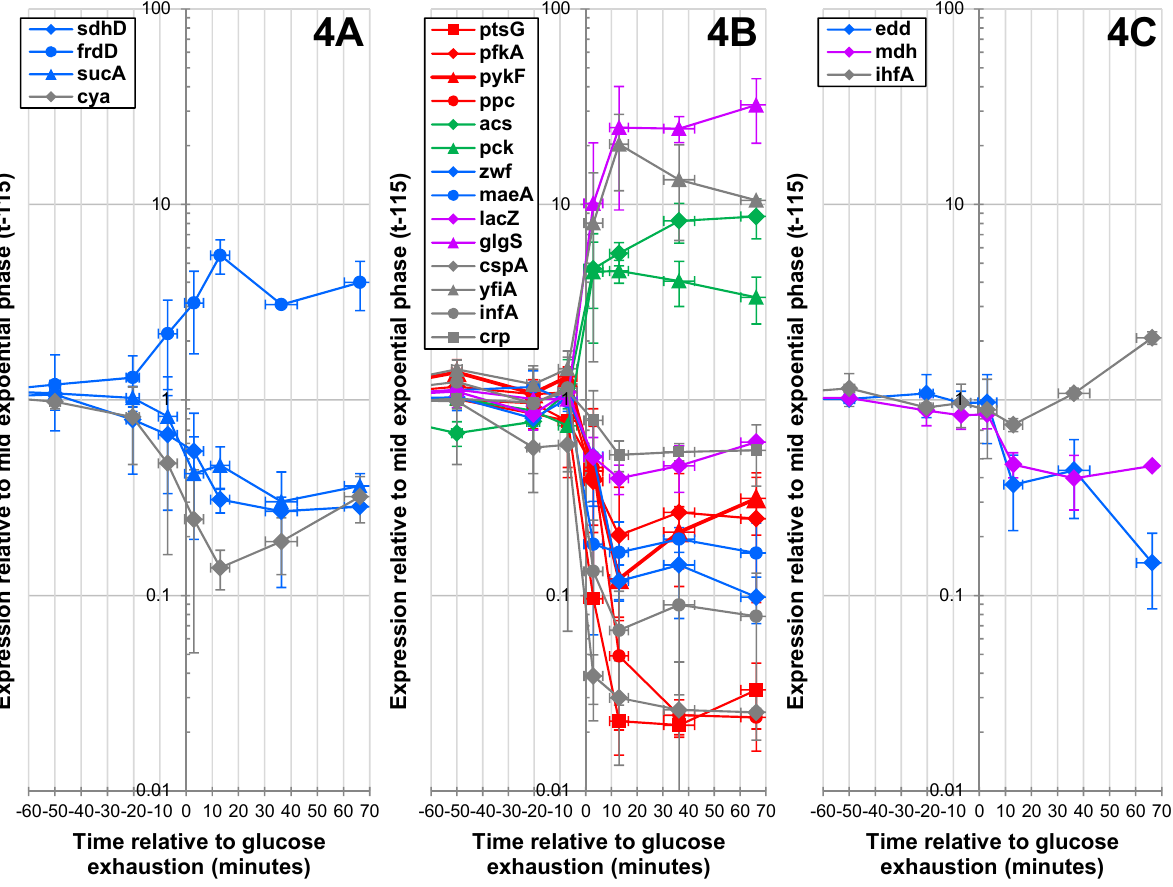
Figure 4. RT-PCR analysis of key gene expressions during the glucose/acetate transition. The plot shows changes in gene expression profiles. Gene expression ratios were normalized according to gene expression levels measured at time –170. ( 4A ) Genes up- or down-regulated before GE. ( 4B ) Genes up- or down-regulated in the three min following GE. ( 4C ) Genes up- or down-regulated more than three min after GE. Glycolytic genes are in red, gluconeogenic genes are in green, blue was used for other central metabolic genes, purple for secondary metabolism genes and gray for non-metabolic